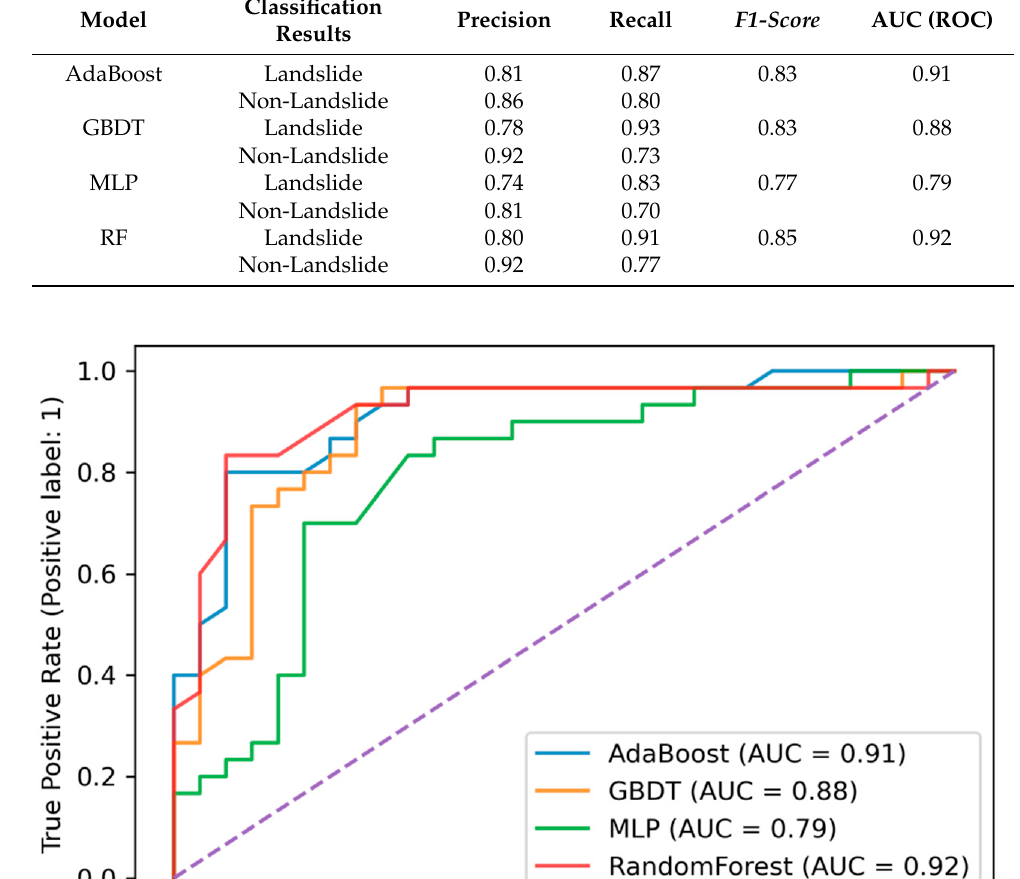
Table 5. The results of cross-correlations among the four models. Number